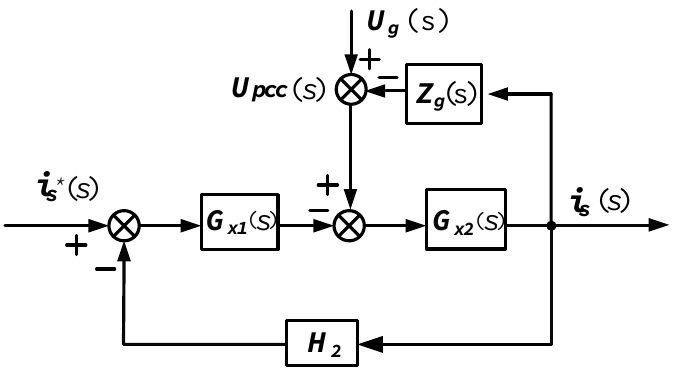
Figure 3. Simplified S-domain model of grid-connected current. In Figure